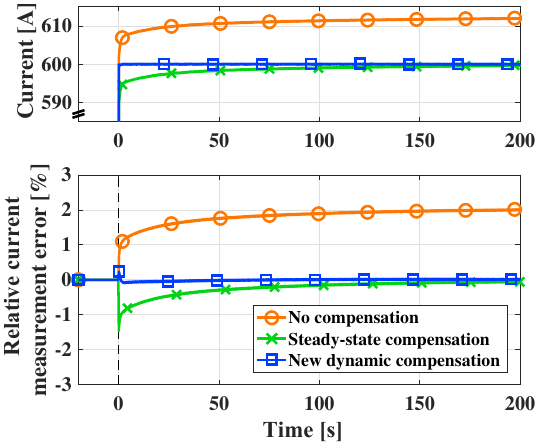
Figure 9. Relative current measurement error after a current step at t = 0s from 0 to 600A for different temperature compensation schemes. Table 5. Arithmetic mean of the absolute value of the relative cur- rent measurement error calculated for the complete testing profile given in Fig.